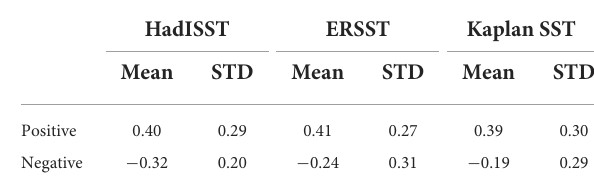
TABLE 1 Comparison of the means and standard deviations of the 7-year running lag correlations during the positive and negative phases based on the three SST